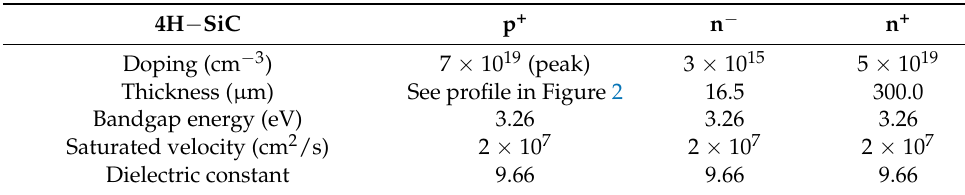
Table 1. 4H − SiC p − i − n regions’ physical